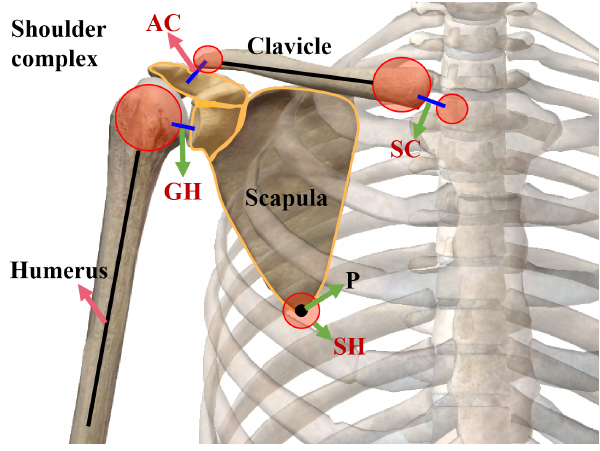
Figure 2. Anatomical structure of the shoulder complex.